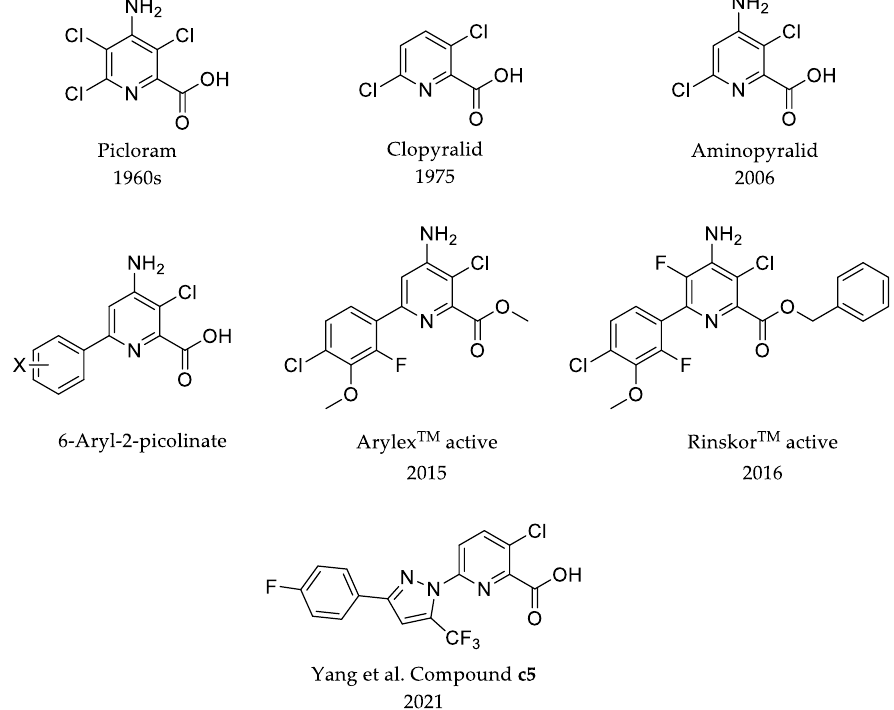
Figure 1. Structures of picolinic acid and 6-aryl-2-picolinate synthetic auxin herbicides. The references involved include [13 – 18].